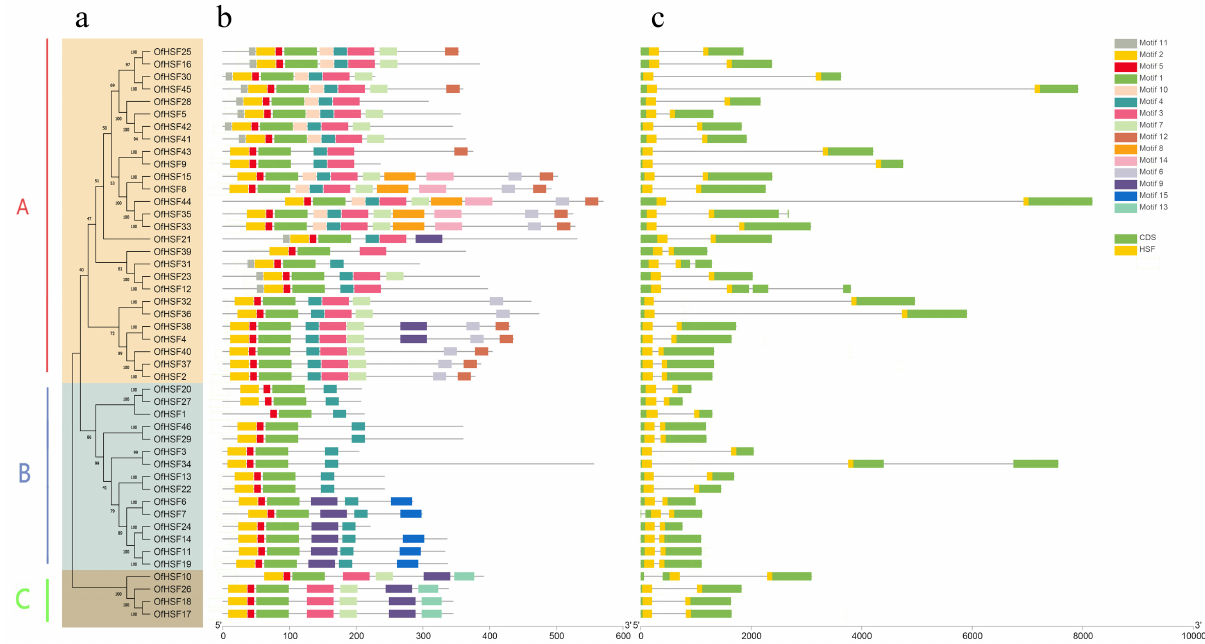
Figure 2. Phylogenetic tree, conserved motif distribution and gene structures of the of OfHSF genes. ( a ) The phylogenetic tree of OfHSF protein sequences was constructed using MEGA11 software,